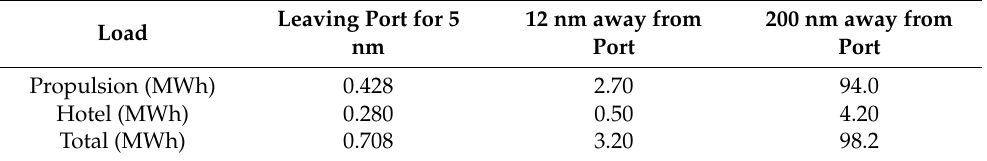
Table 15. Energy consumption data for an 82,000 dwt bulk carrier [10].